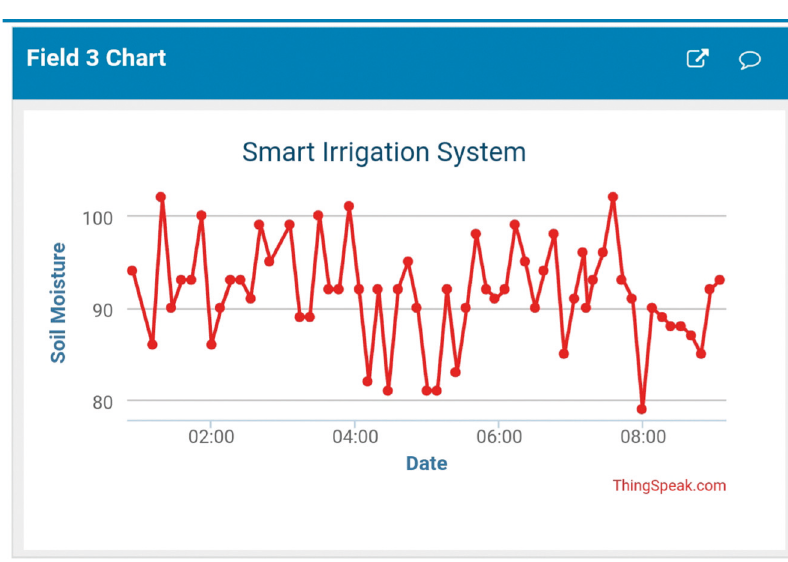
Figure 13: Soil moisture.